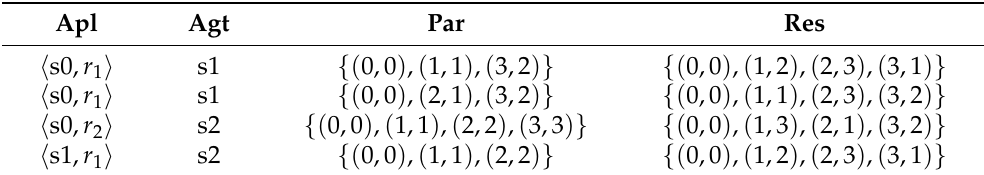
Table 3. The Tracking Transition System for the introductory example. Each row defines a single transition in the